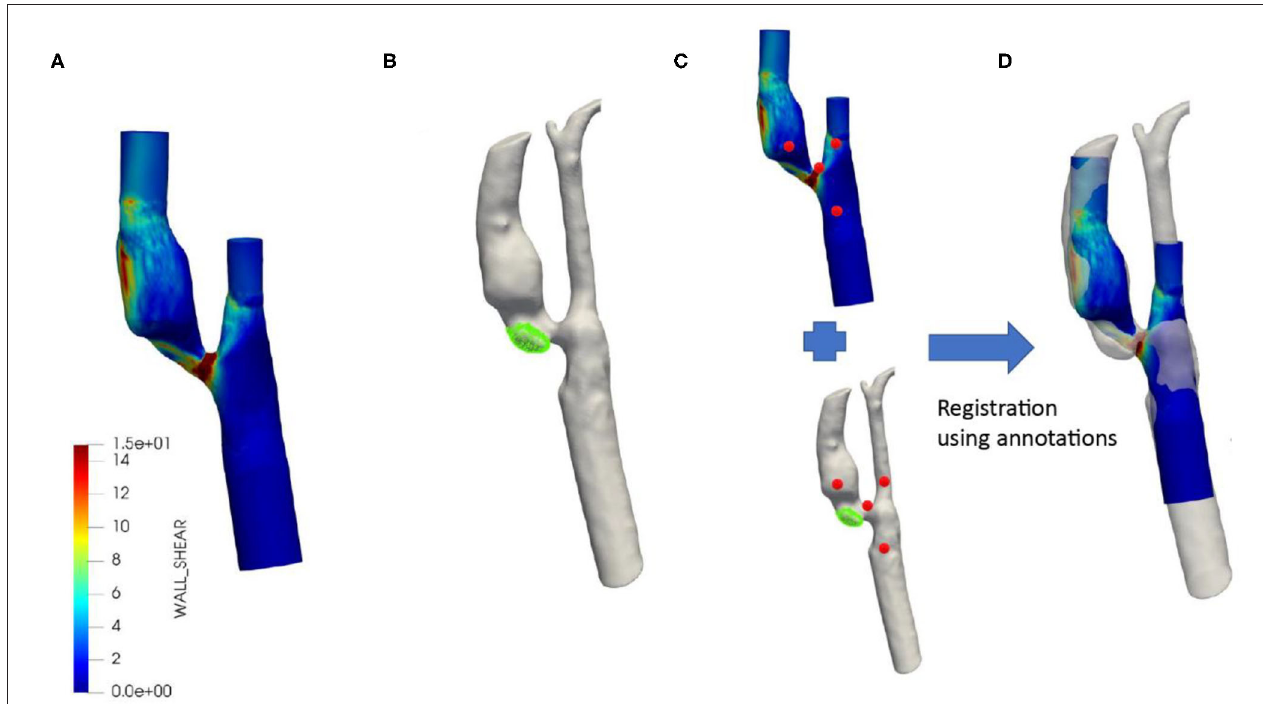
FIGURE 1 | Typical example of co-registered baseline wall shear stress distribution with follow-up MDCTA. WSS distribution over the symptomatic carotid artery based on MRI baseline contours and flow as measured by Duplex (A) . Segmented MDCTA follow-up lumen with the new ulcer shown in green (B) . Registration between MRI baseline and MDCTA follow-up using annotations (red) (C) . Final registration of baseline MRI including wall shear stress and MDCTA with new ulcer (D)